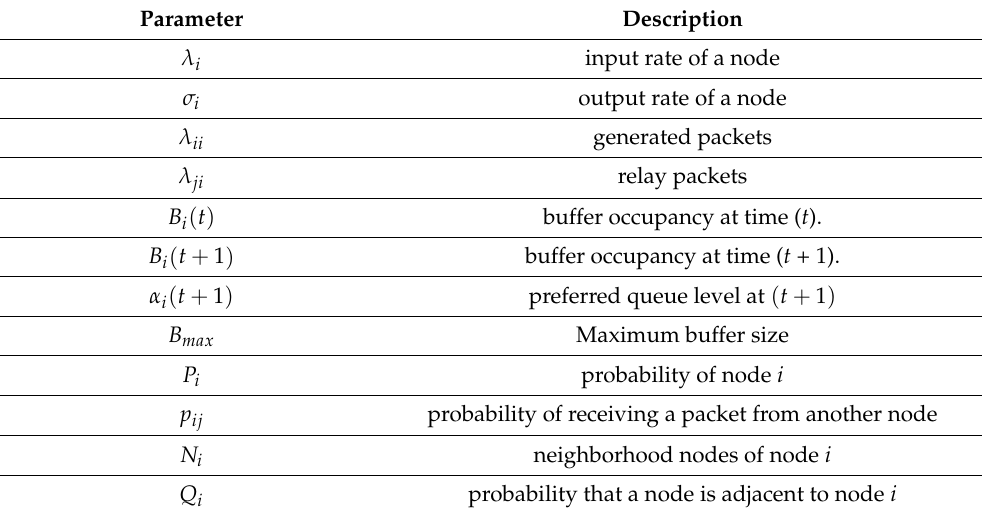
Table 1. Description of